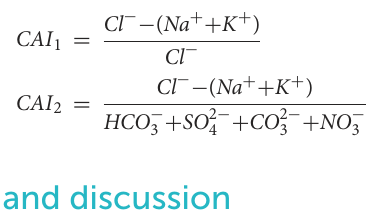
exchange between groundwater and the host environment. In the following equations, the unit for the concentration of all ions is mEq/L. Table 1. The groundwater pH ranges from 7.1 to 8.2 with an average value of 7.6, indicating neutral to slightly alkaline water. The highest